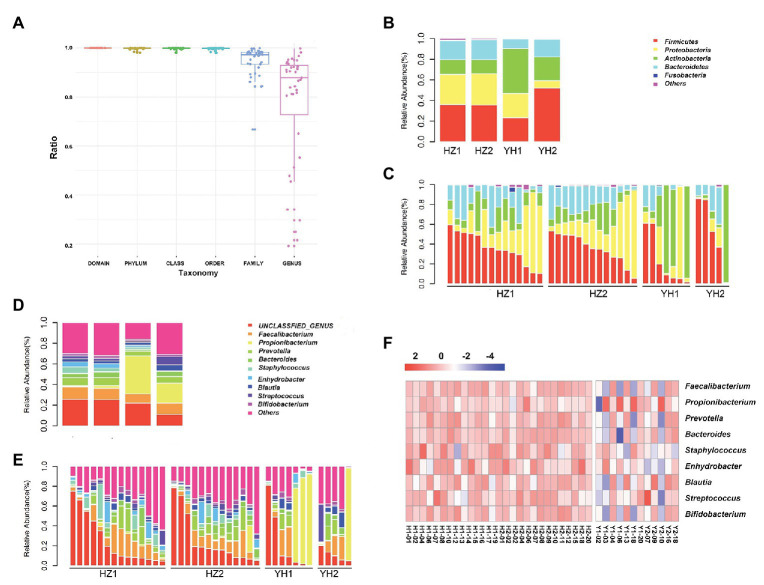
Taxonomy resolution of facial bacterial microbiome in healthy female individuals between the HZ and YH groups. (A) Taxonomy resolution in all samples; each bar represented ratio of reads annotated at that level. (B,C) Relative abundance levels of the phyla presented in samples from the HZ and YH healthy female individuals. (D,E) Relative abundance levels of genera presented in samples from the HZ and YH female individuals. (F) The heatmap of the most dominated genera of the facial microbiome. HZ1 and H1 indicated data of oily zone in the HZ district, HZ2 and H2 indicated data of dry zone in the HZ district, YH1 and Y1 indicated data of oily zone in the YH district, and YH2 and H2 indicated data of dry zone in the YH district.